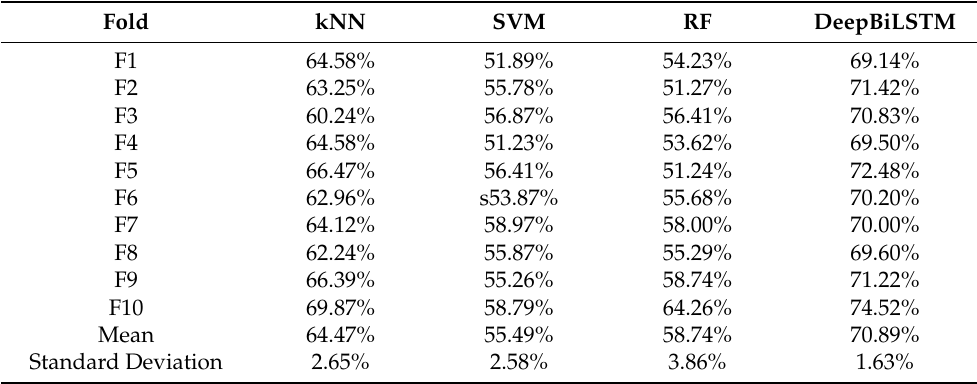
Table 2. Accuracy, mean and standard deviation results of positive-negative emotions.